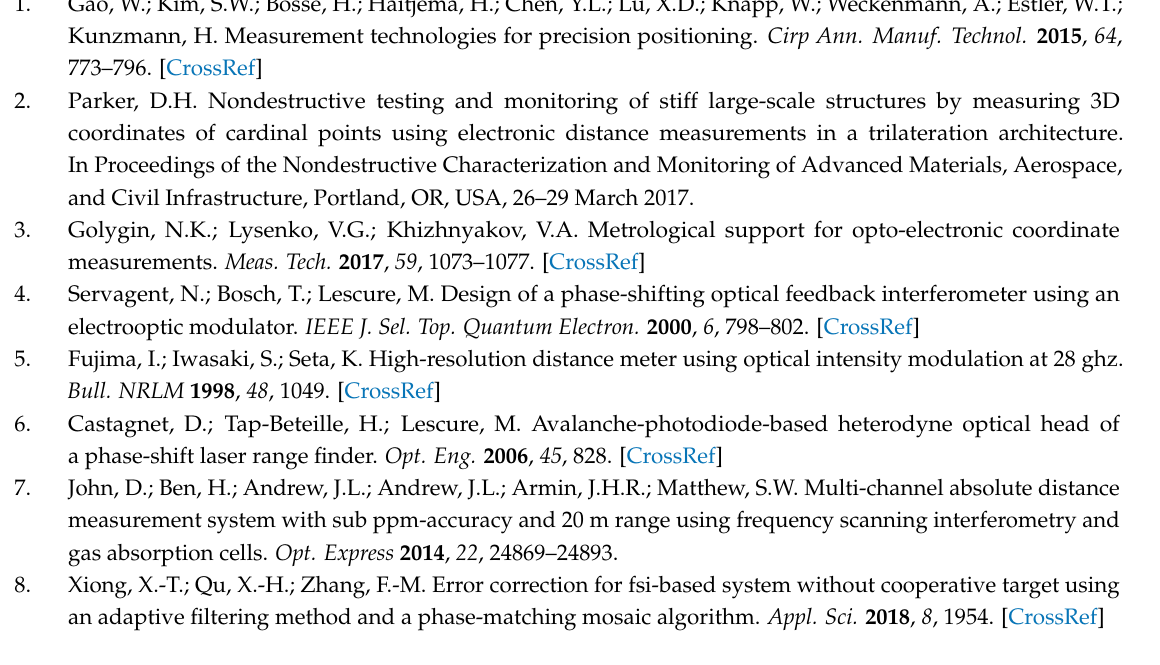
Figure 7. Residuals of the measured distance versus displacement from a commercial heterodyne